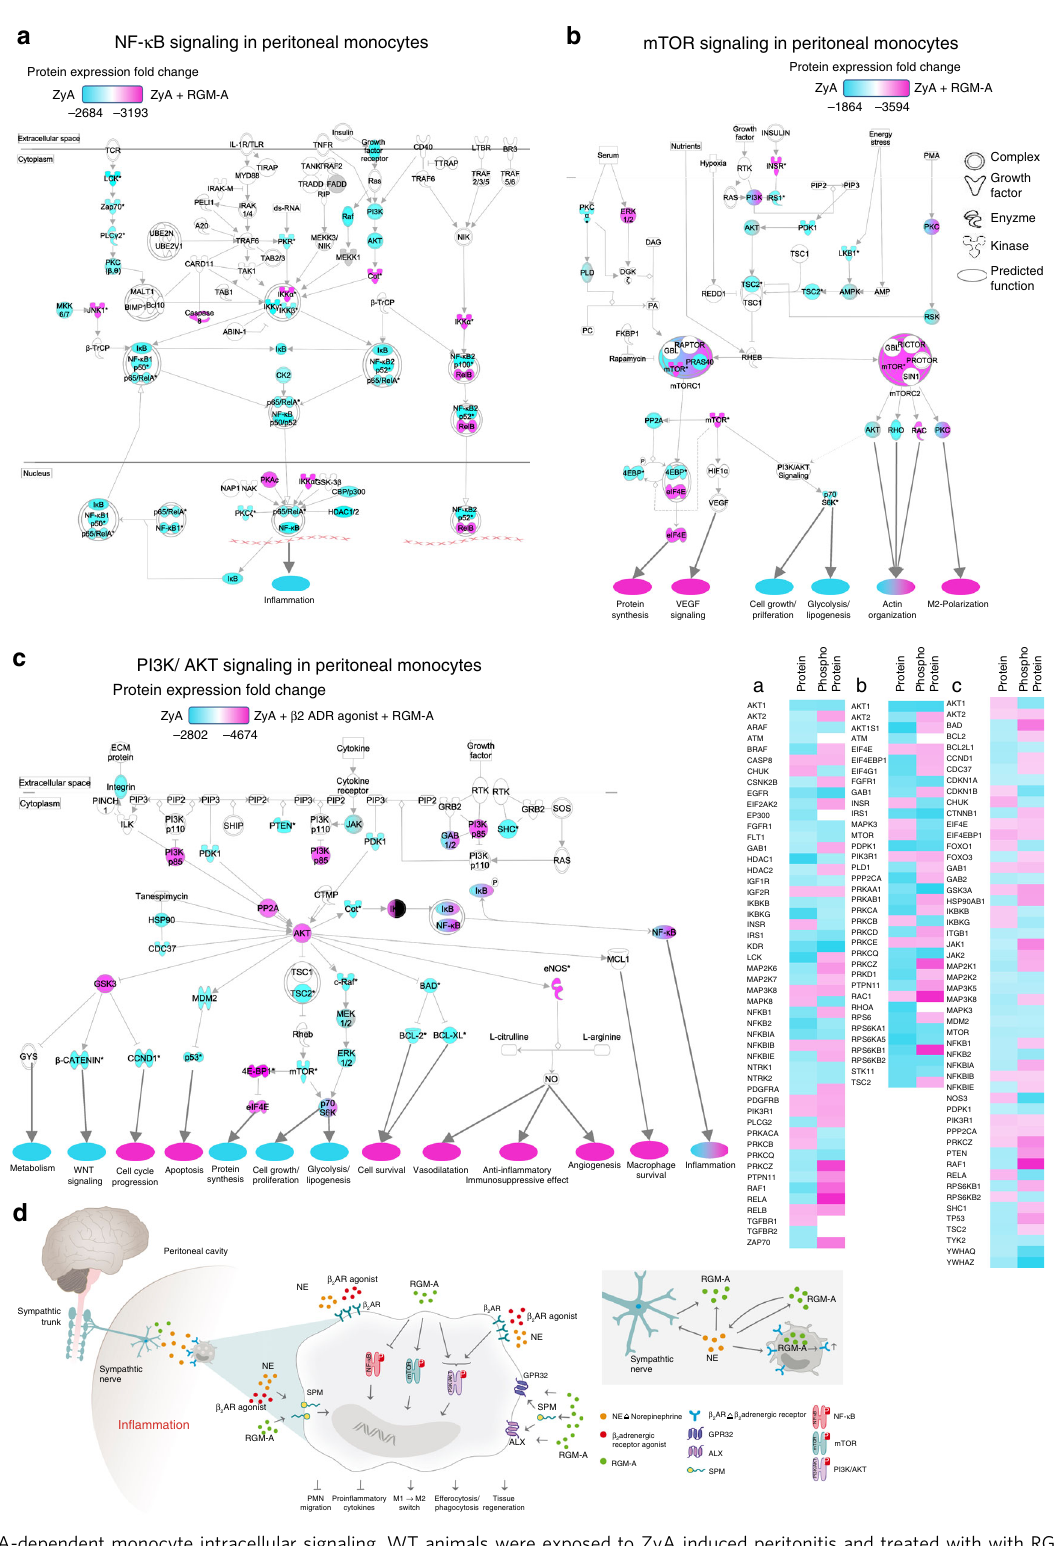
κ B, b the mTOR, and c the PI3K/Akt signaling